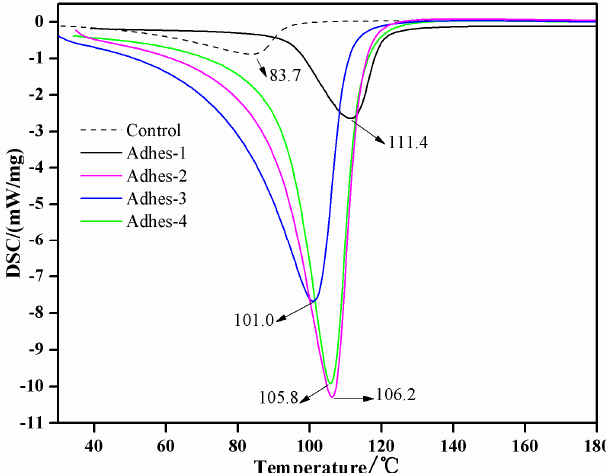
Figure 2. DSC results of Camellia oleifera cake-protein adhesives. Note: Control, pure Camellia oleifera cake-protein hydrolysate; Adhes-1, the pure Camellia oleifera cake-protein adhesive; Adhes-2, Camellia oleifera cake-protein adhesive modified with DSP; Adhes-3, Camellia oleifera cake-protein adhesive modified with SPI; Adhes-4, Camellia oleifera cake-protein adhesive modified with casein. Integral processing was performed for the curing peaks of DSC curves in Figure 2.